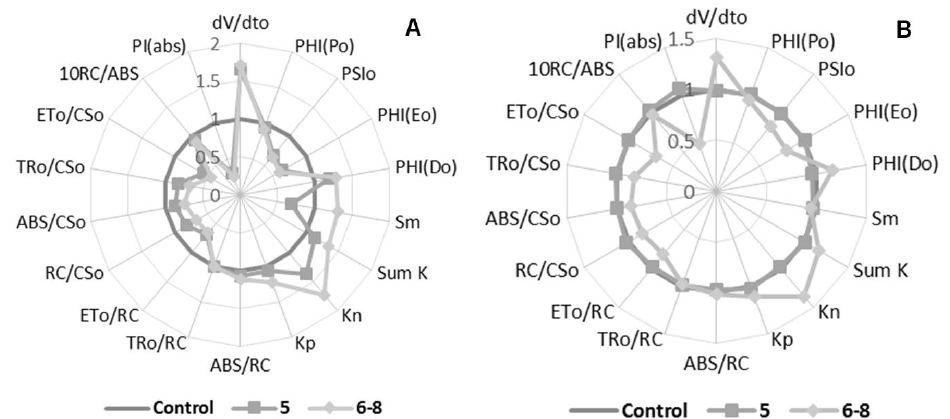
Figure 3. Radar plot of Compounds 5 and 6 – 8 effects on Chl a fluorescence parameters calculated from an OJIP transient curve. Panel ( A ) 150 μ M, and Panel ( B ) 300 μ M.